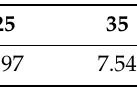
Figure 1. The optical photographs of the samples fabricated at different electrolyte temperatures: ( a ) 5 °C; ( b ) 15 °C; ( c ) 25 °C; ( d ) 35 °C. Table 5. Thickness of the